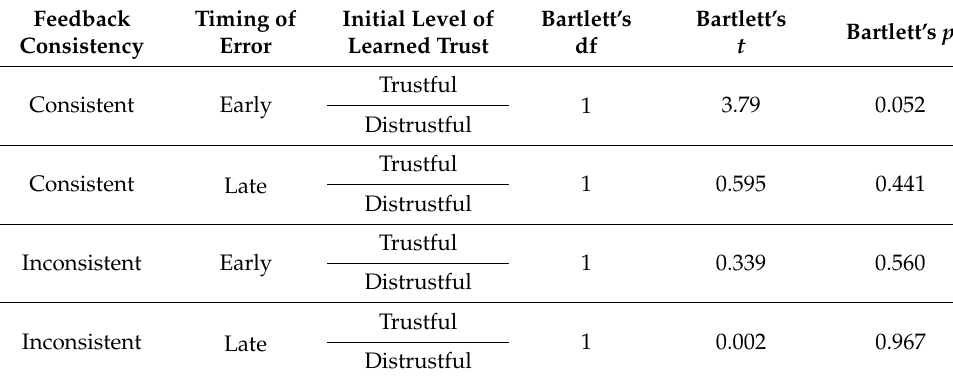
Table 3. Bartlett’s t -tests for participants’ initial level of